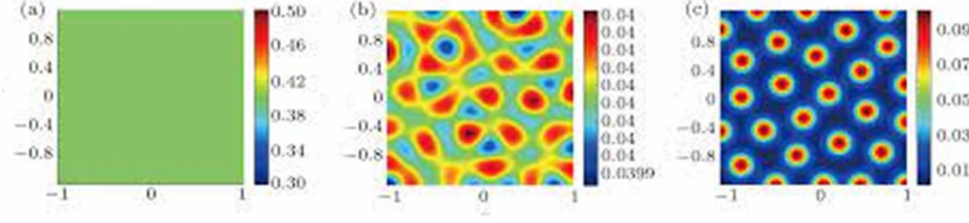
Figure 5. Spatial patterns in Gierer- Meinhardt MCNN (1): ( a ) after 0 iterations; ( b ) after 1000 iterations; ( c ) after 5000